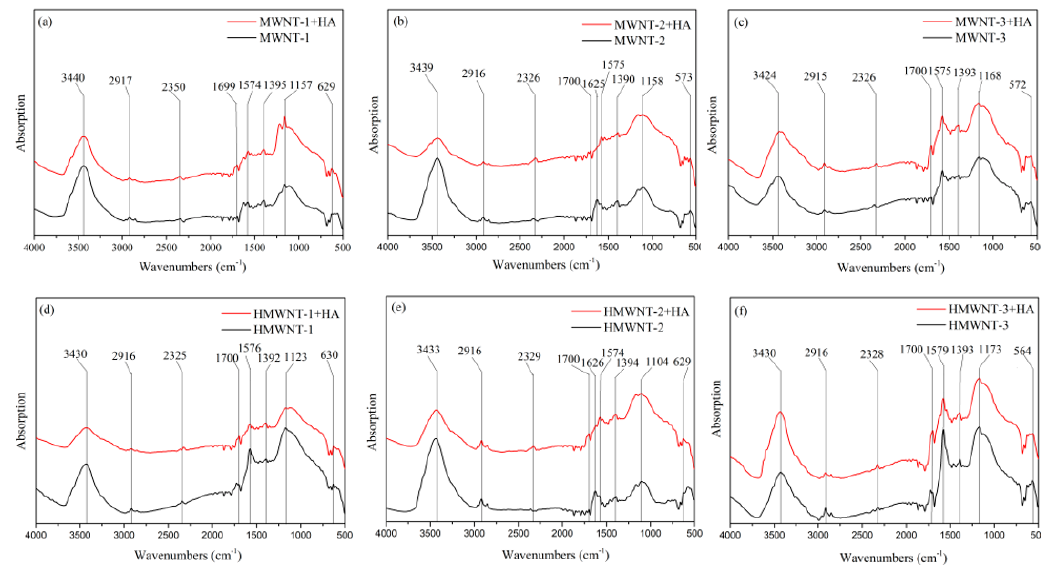
Figure 11. FTIR spectra of MWNTs ( a – c ) and HMWNTs ( d – f ) prior to and after HA adsorption.